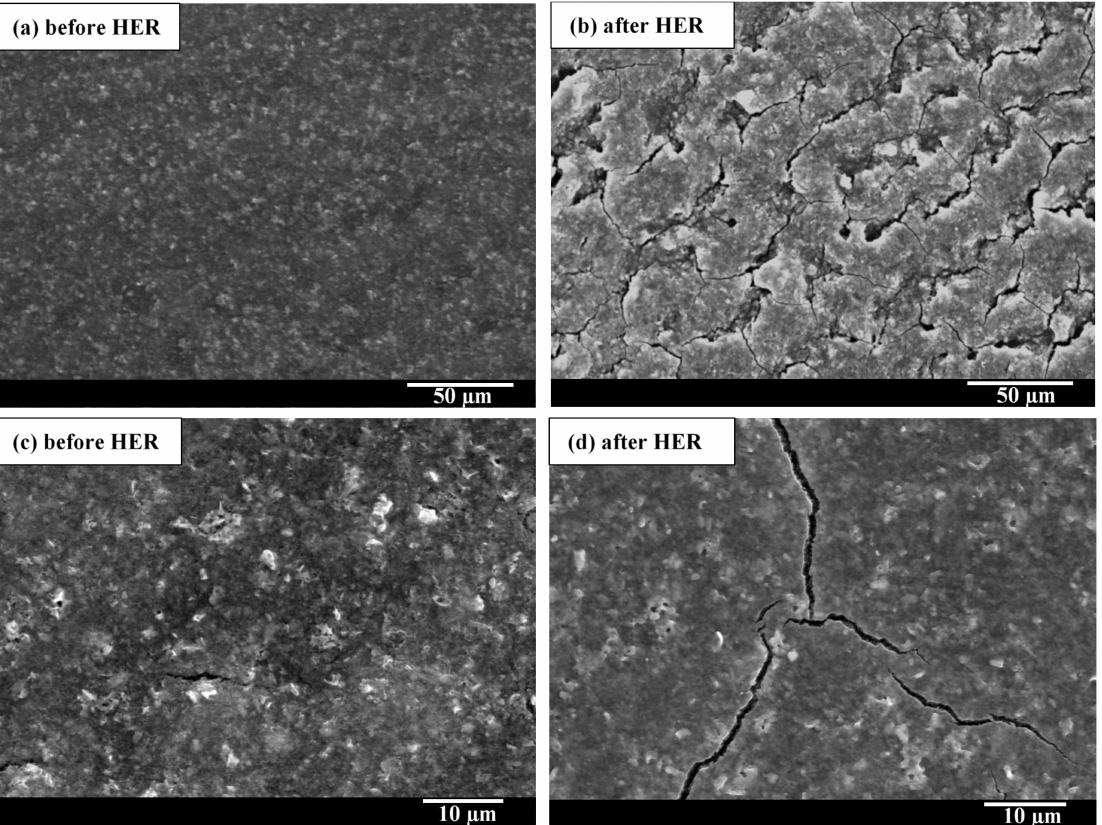
Figure 6. Selected SEM images showing the NiMoO 4 /CB/Nafion electrocatalyst layer (same specifi- cations as those indicated in the caption of Figure 5) before ( a , c ) and after electrolysis ( b , d ) at different magnifications. The label “Before HER” refers to the sample not subjected to electrolysis, while “After HER” denotes the sample after 24 h of